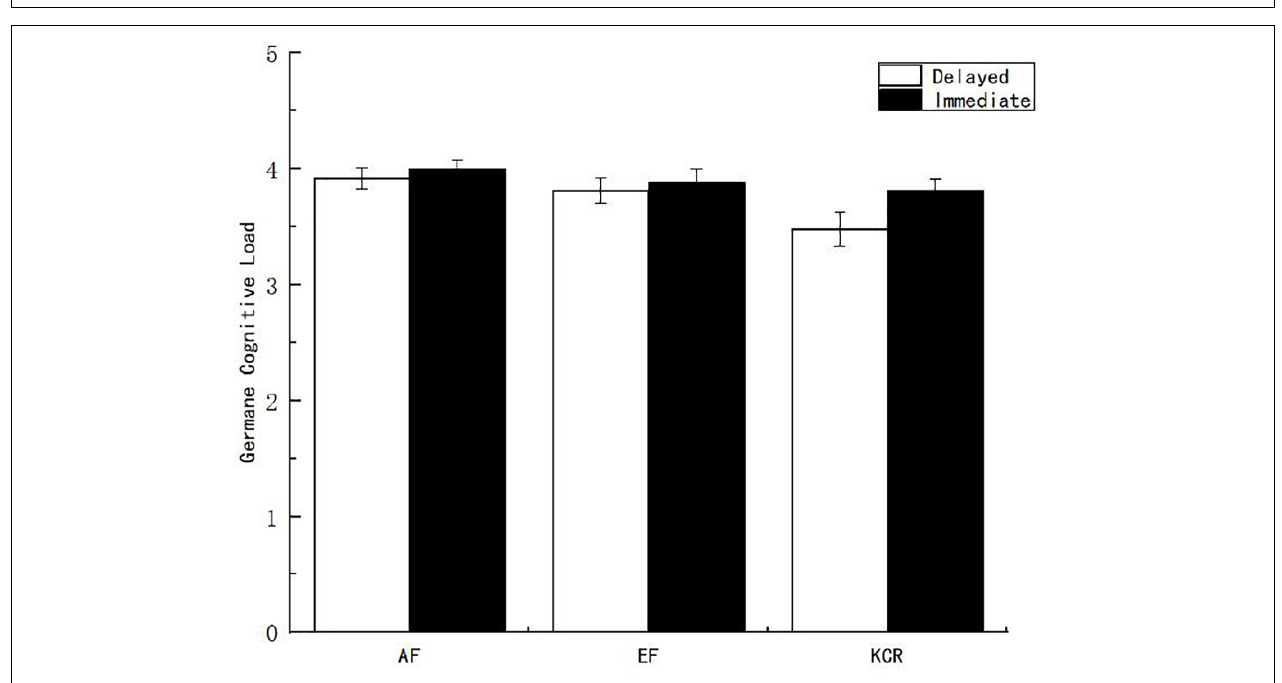
FIGURE 3 | Germane cognitive load of learners under different feedback